Question: Write a single sentence explaining what this figure depicts.
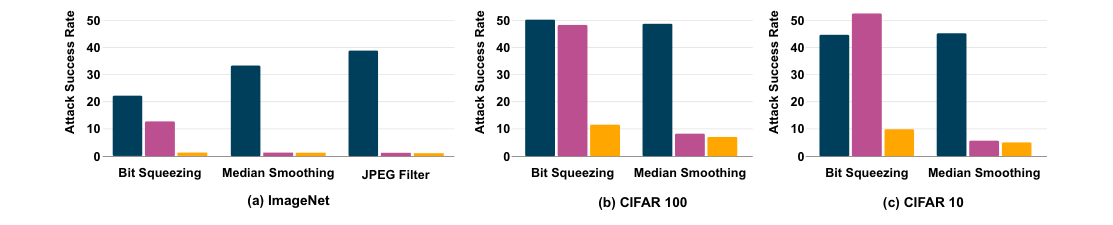
Answer: The effectiveness of the various defensive strategies and observes how they bring the percentage of successful attacks down from 100%. Note that JPEG defense could not be applicable to CIFAR dataset due to the smaller size of the images.